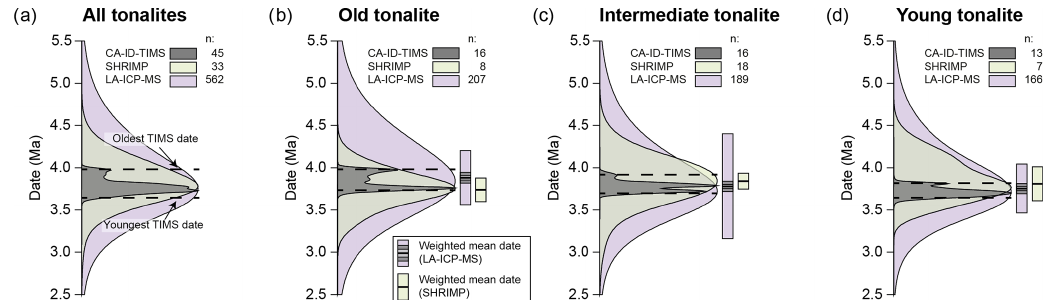
Figure 11. Probability density plots for the geochronology data for each analytical technique. All dates of each technique are combined in panel (a) . Plots in panels (b) , (c) , and (d) are constructed from the data of the old, intermediate and young tonalite. Dashed lines indicate the youngest and oldest zircon crystallisation age as determined by CA–ID–TIMS for the respective investigated dataset. Weighted means, standard error, standard error + 1.5% (Horstwood et al., 2016) and standard deviation are shown by bars with three colours to the right of each diagram. These are identical to those in Fig.